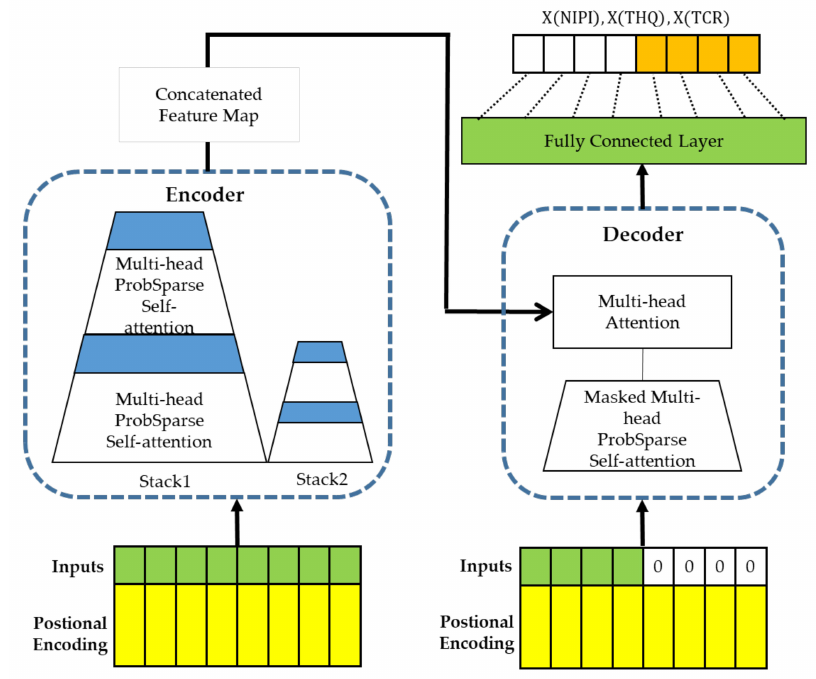
Figure 2. Predictive model of rice safety risk assessment indicator based on